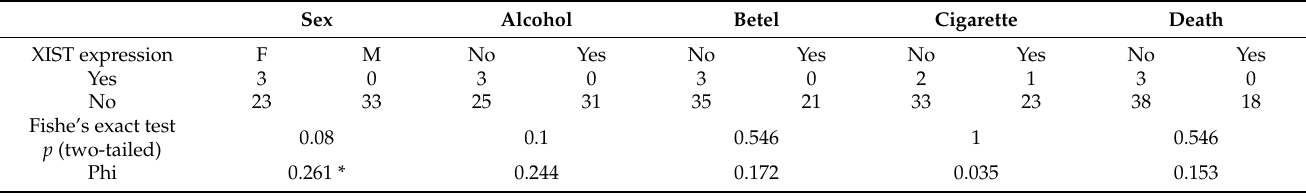
Table 3. The correlation and significant difference between XIST expression and clinical pathological data among OSCC patients.